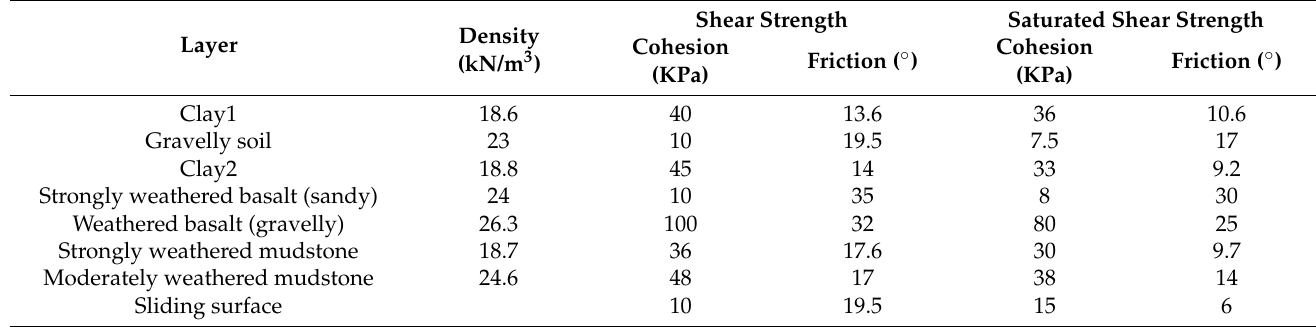
Table 2. Parameters of each layer.